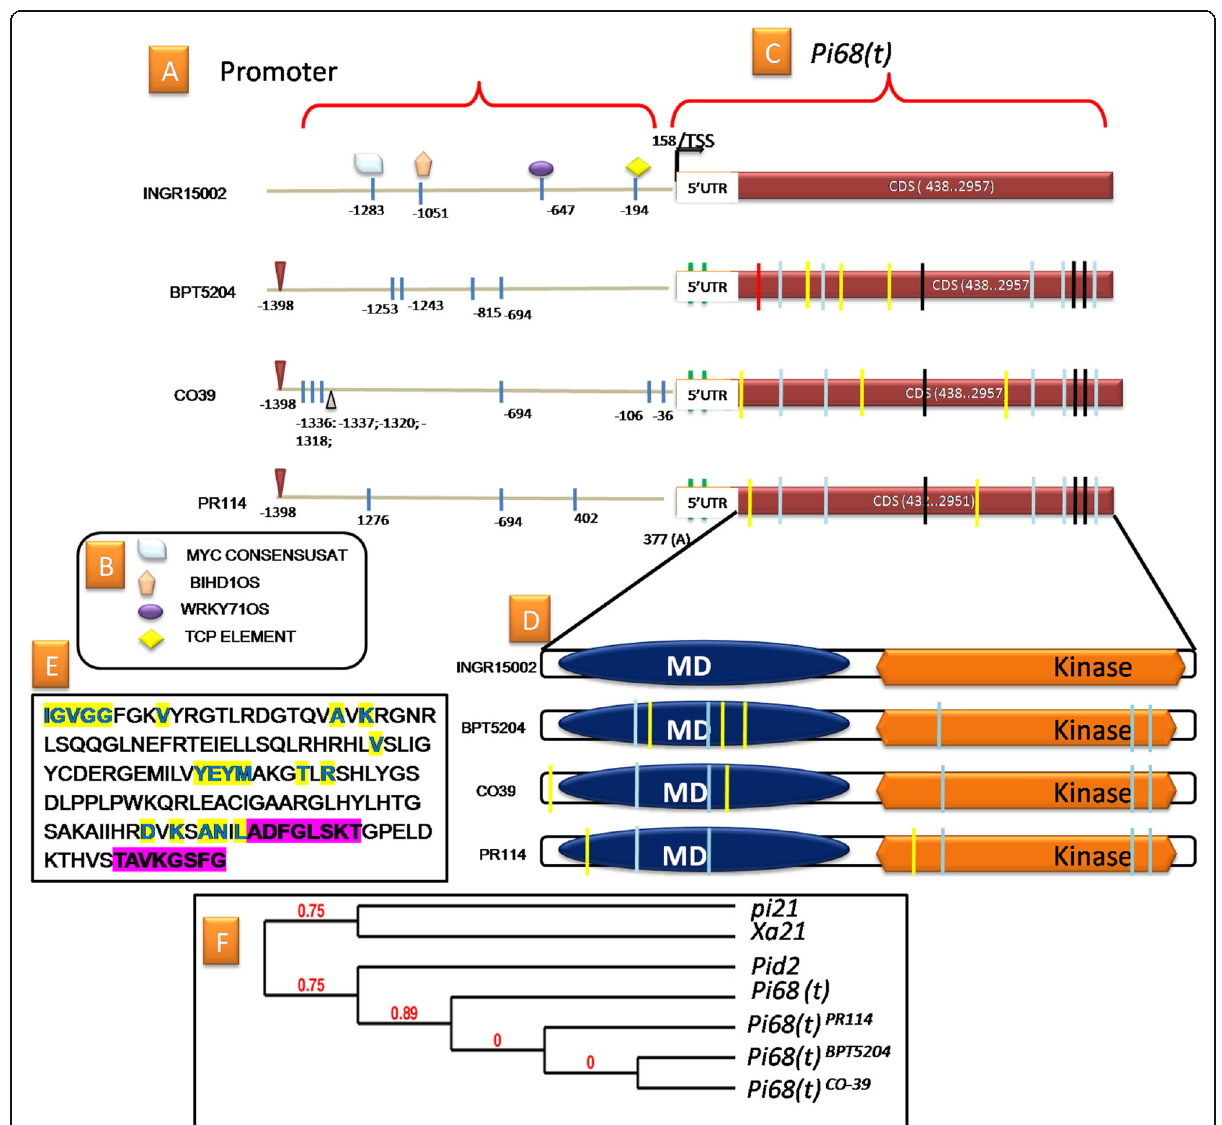
Fig. 2 Promoter and gene characterization of Pi68(t) alleles in resistant and susceptible lines. a The number written in the promoter region indicates the position of SNPs identified in each sequence. The SNP leading to the presence/absence of TFBM was shown using different shapes. The triangle (Black) in CO39 promoter indicates the single base pair deletion and the triangle (red) indicate single base pair insertion. b The list of TFBMs identified in the promoter region and function of each motif is given in Table S12. c The TSS and coding sequence of Pi68. The two SNPs exist in the 5 ’ UTR region were indicated in black bars. The blue bars in the coding sequence region indicate the common SNPs in the susceptible alleles leading to non synonymous changes. The black bars in the coding sequence region represent the common SNPs in the susceptible alleles leading to synonymous changes. The yellow bars in the coding sequence region are the allele specific SNPs leading to non synonymous changes. The red bars in the coding sequence region are the allele specific leading to synonymous changes. The position of the SNP and its Synonymous and Non Synonymous substitutions of amino acid are tabulated in Table S11. d The functional domains of the predicted protein. e The signature sequences of the active and ATP binding sites were highlighted in yellow and the signature sequences of Activation Loop and polypeptide binding site were highlighted in pink. f Cladogram representing the relationship of the Pi68 with earlier reported kinases of rice blast ( pi21; Pid2 ) and bacterial blight ( Xa21